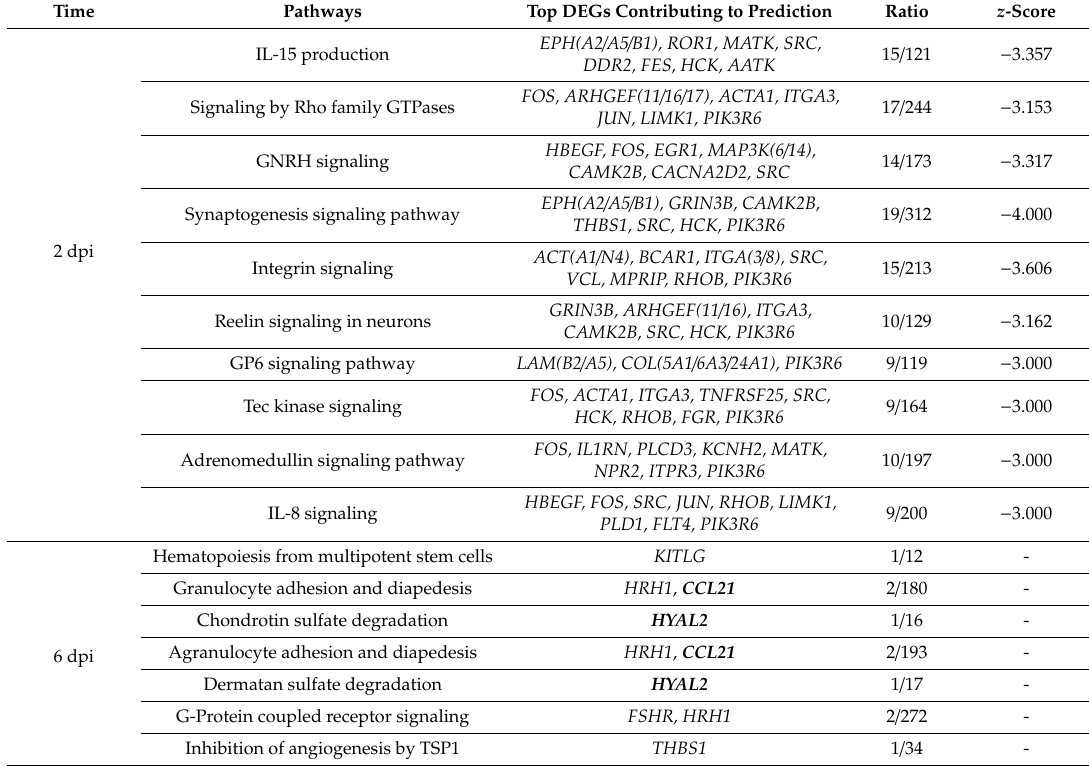
Bold italic and italic text respectively indicate higher and lower expression of di ff erentially expressed genes (DEGs) in NDV-challenged chickens compared to non-challenged group. Genes are ranked ascendingly based on their fold change from left to right. Genes within the same family are labeled with the member or subunit names in the brackets. Ratio = (number of DEGs in a pathways) / (Total number of genes in the